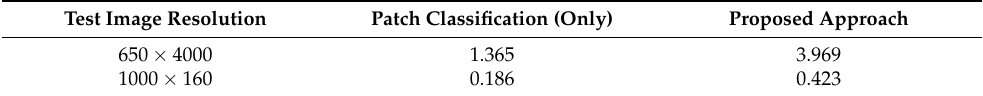
Table 3. The run-time (seconds) performance of the proposed